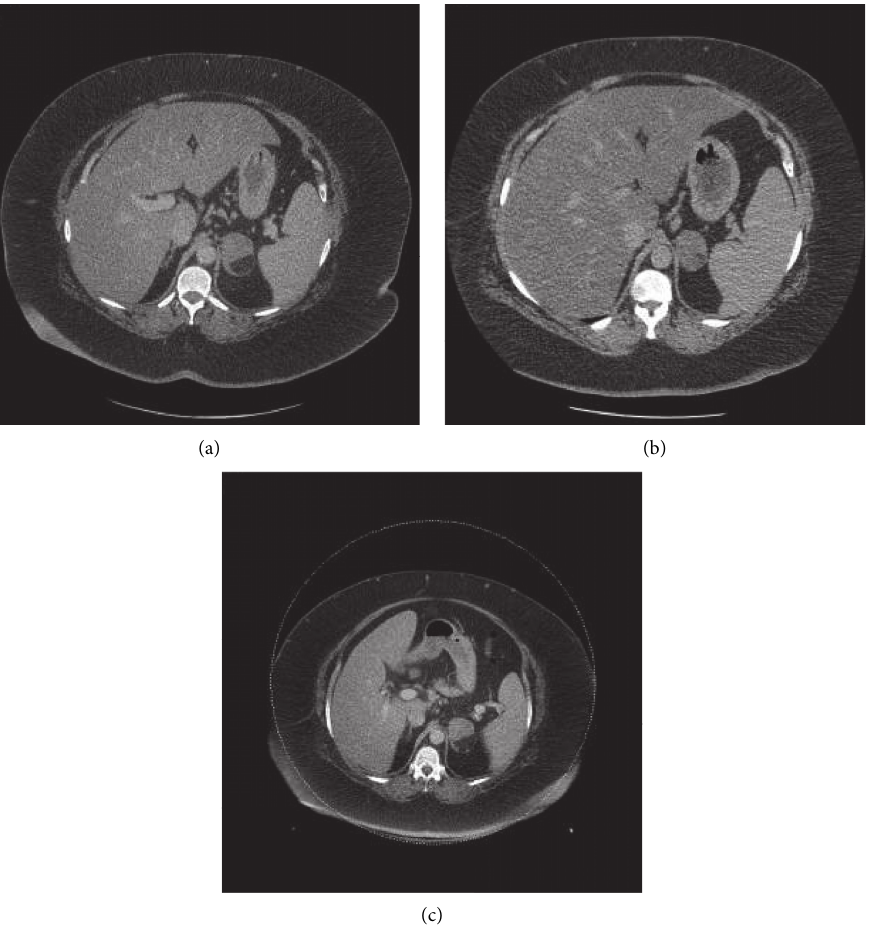
Figure 1: A CT for abdominal pain in November 2012 revealed a presumed adrenal myelolipoma with a focus of macroscopic fat (a). In comparing to a prior exam from April 2007 (b), this mass had grown in size, and subsequent imaging from April 2016 (c) continued to demonstrate